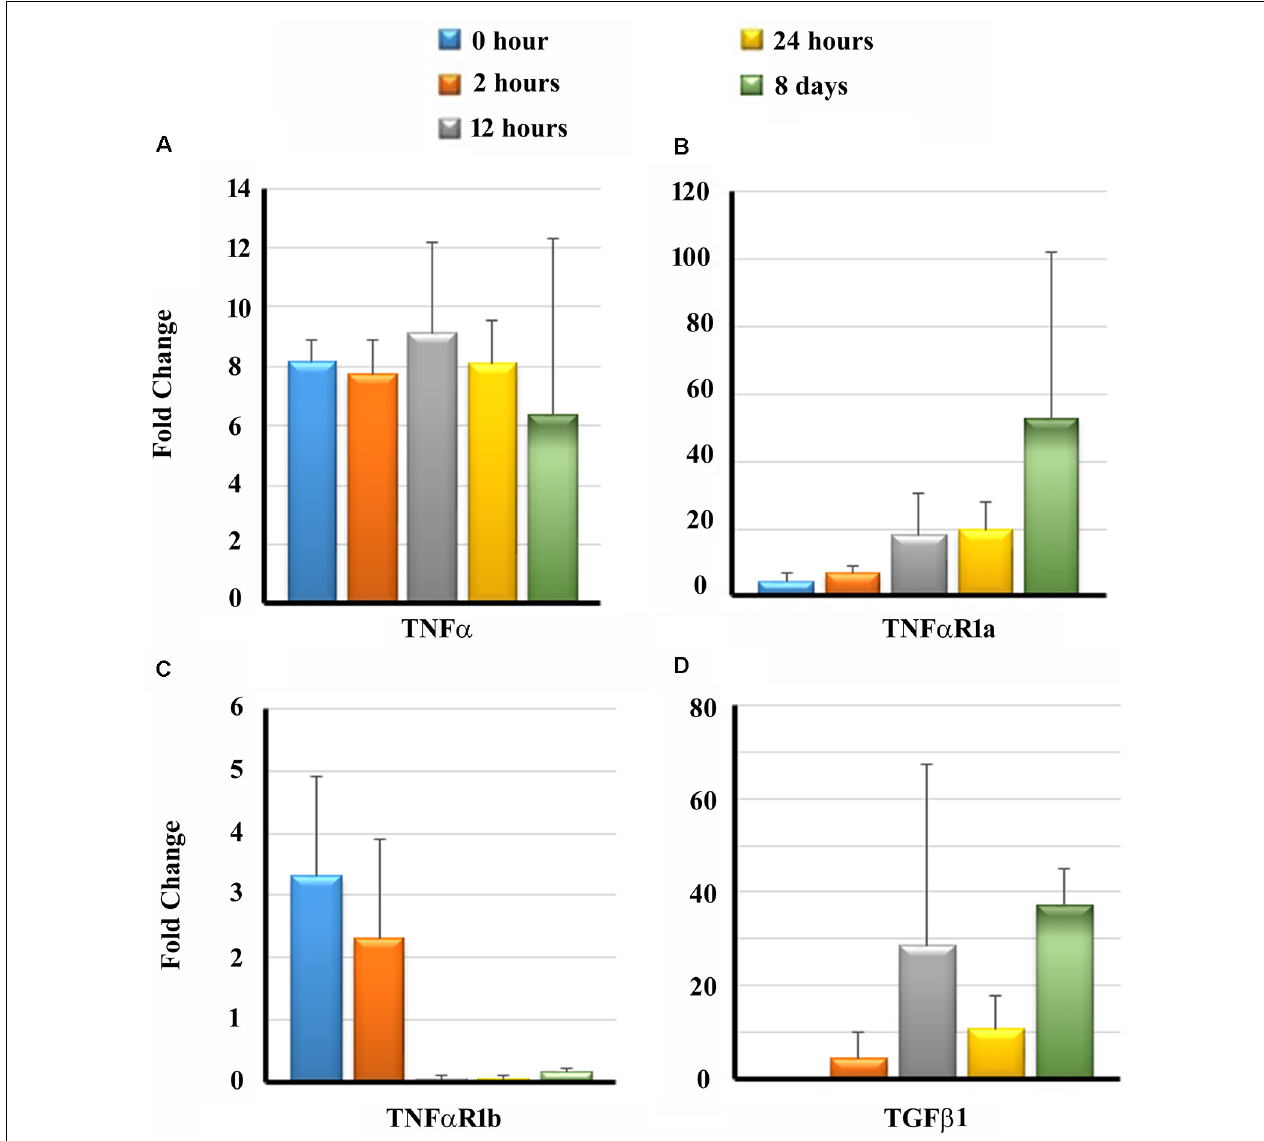
FIGURE 4 | Transcripts levels of pro-inflammatory and pro-fibrogenic genes in the cochleae. Guinea pigs were subjected to NT and cochleae were harvested at different post-NT time periods. The expression of tumor necrosis factor- α (TNF- α ; A ), TNF- α receptor 1a (TNF α R1a; B ), TNF α R1b (C) and transforming growth factor β 1 (TGF β 1; D ) was determined by real-time PCR. Time zero represents cochleae harvested immediately after NT. Data are expressed as fold change compared to the control group and represents mean ± standard